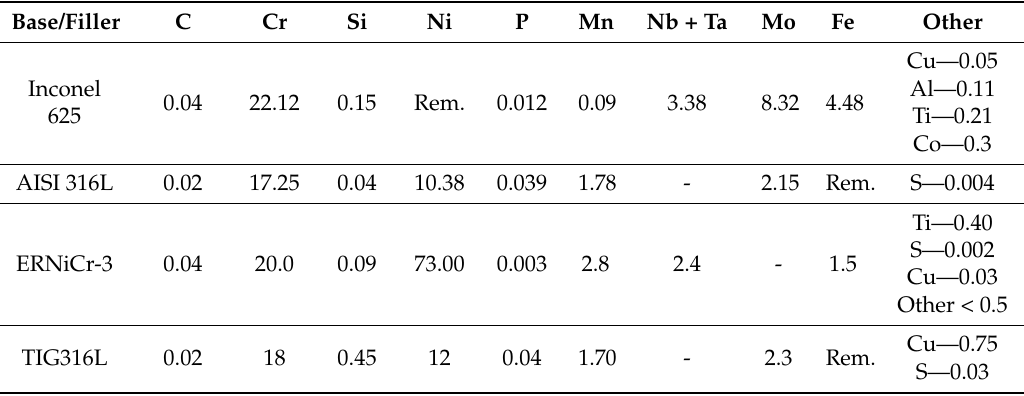
Figure 1. Semi-automatic Gas Tungsten Arc Welding (GTAW) setting. Table 1. Chemical composition of the base and filler metals (wt